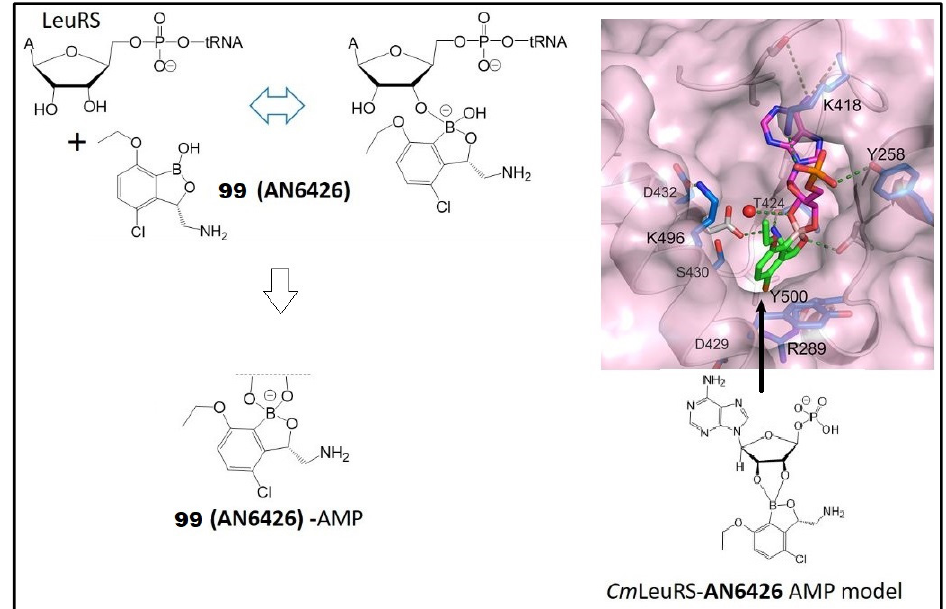
Figure 14. Formation of AN6426-adenosine adduct (left) and crystal structures of post-transfer editing analogues and AN6426 with Cm LeuRS (right). (Adapted from [127]).